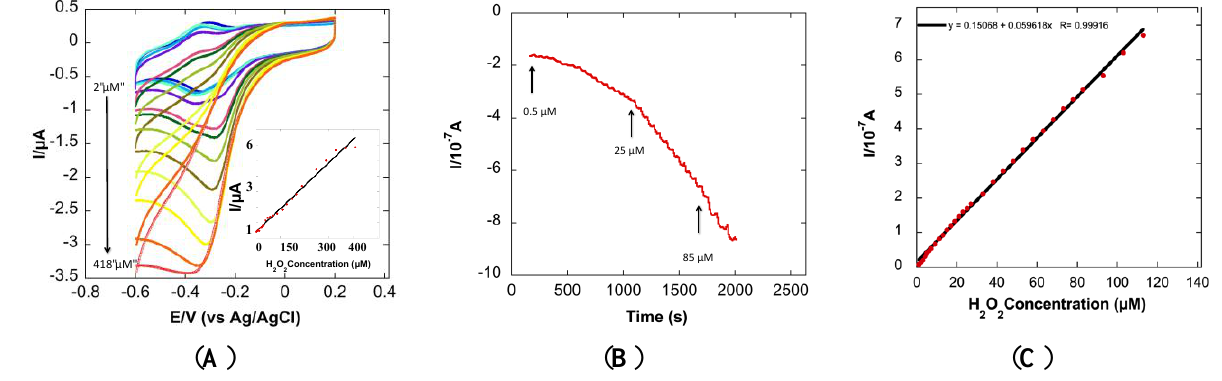
Figure 5. ( A ) Cyclic Volatmmograms of Hb-PAA-450k(1:0.8:1.5) modified GC electrode at different concentration of H 2 O 2 (Inset: corresponding calibration plot); ( B ) Amperometric response of Hb-PAA modified electrode with successive additions of H 2 O 2 in PB pH 7.4 at an applied potential of −0.335 V at 25 °C; ( C ) Corresponding calibration plot of amperometric response towards H 2 O 2 . Table 2. Relevant data from recently reported Hb-based H 2 O 2 biosensors. Electrode Applied